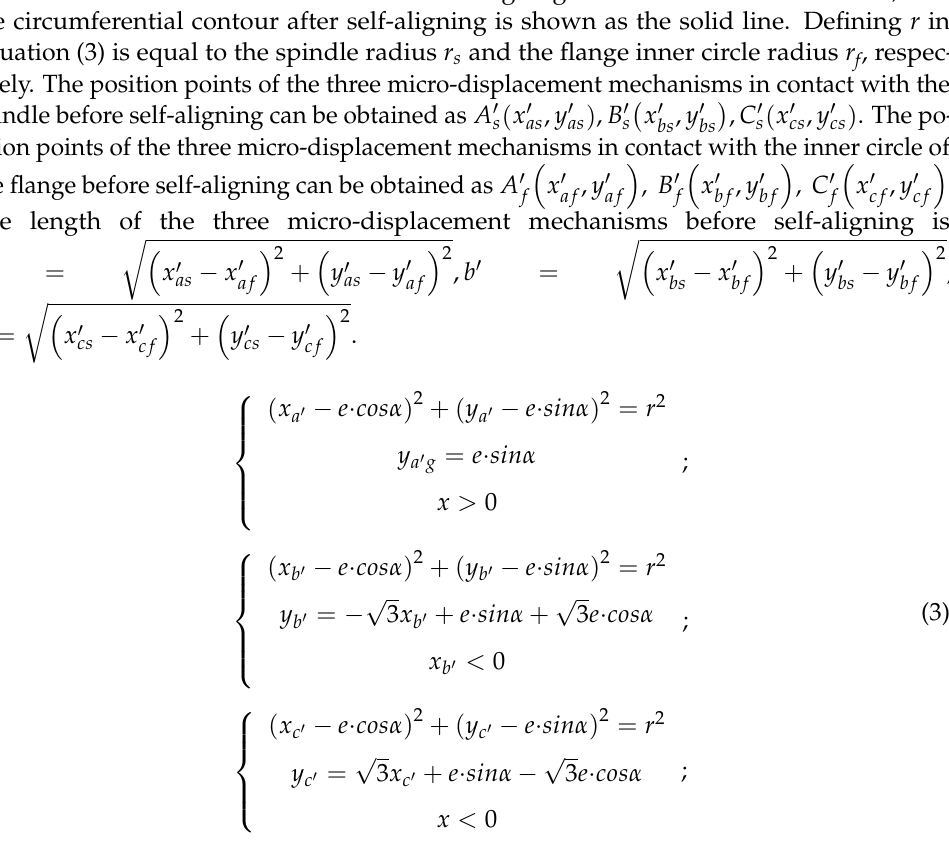
(cid:1) (cid:0) ( x (cid:48) ) , B (cid:48) ( x (cid:48) ) . The po- x (cid:48) , y (cid:48) , y (cid:48) , C (cid:48) , y (cid:48) s as as s s cs cs bs bs (cid:16) (cid:17) (cid:16) (cid:17) (cid:16) (cid:17) x (cid:48) x (cid:48) x (cid:48) , y (cid:48) , B (cid:48) , y (cid:48) , C (cid:48) , y (cid:48) . f af af f bf bf f cf cf